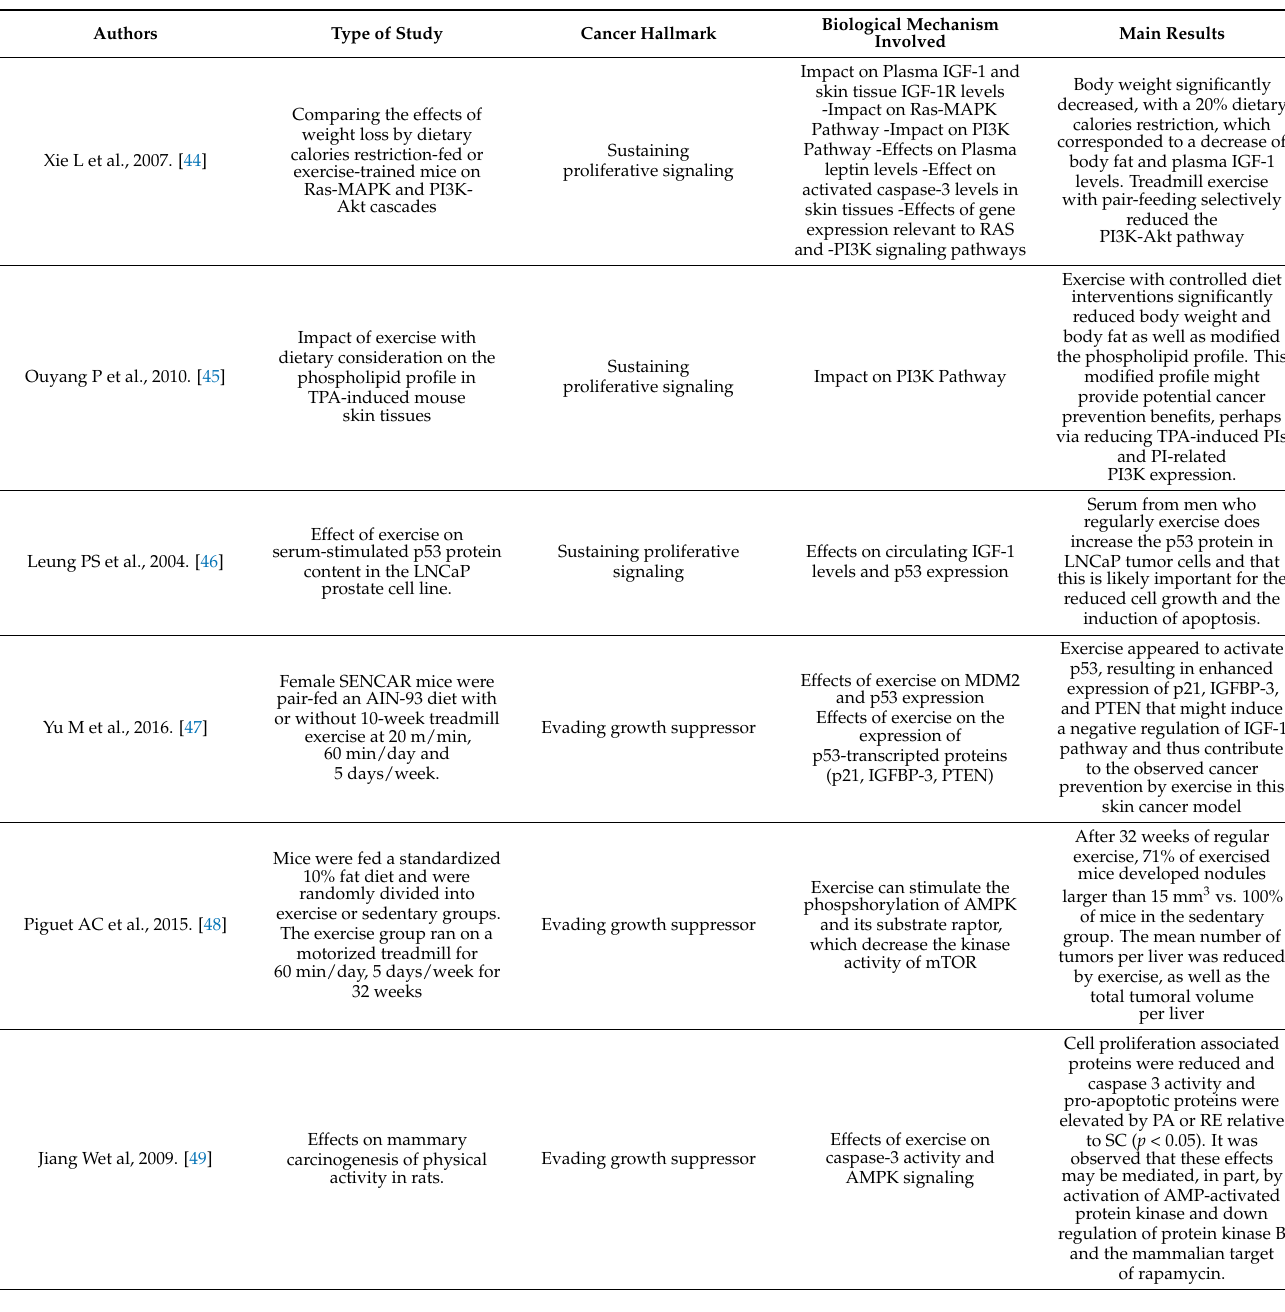
Table 1. Main characteristics and results of preclinic studies included in the systematic